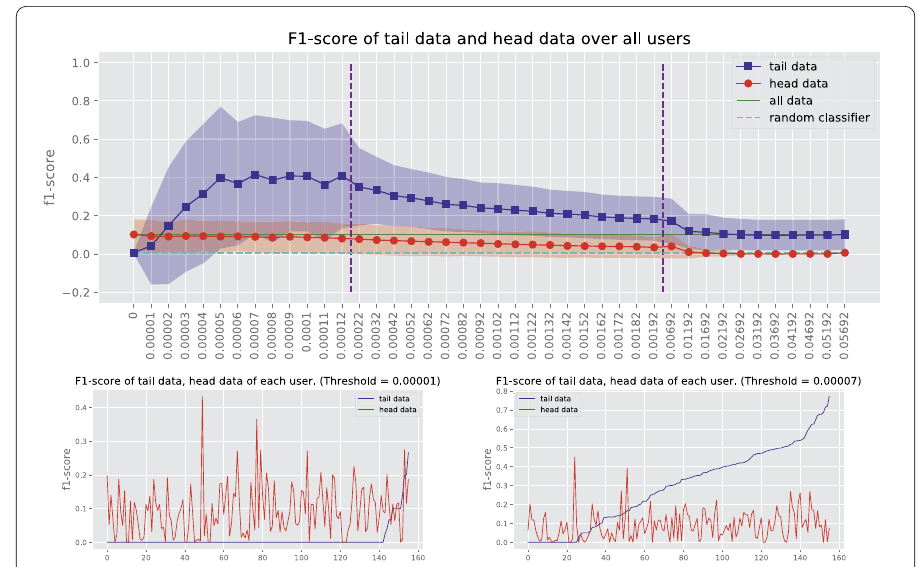
Figure 10 Top: average F 1 score over all study participants for classifiers trained on tail (blue) and head (red) data for increasing values of the threshold τ . The performance of a classifier trained on all data (green) and of a random baseline (cyan, dashed) are also reported, for comparison. Bottom: F 1 score of each individual for thresholds τ = 0.00001 (left) and τ = 0.00007 (right). The x -axis represents the 156 participants. Individuals are sorted by increasing F 1 score of the tail